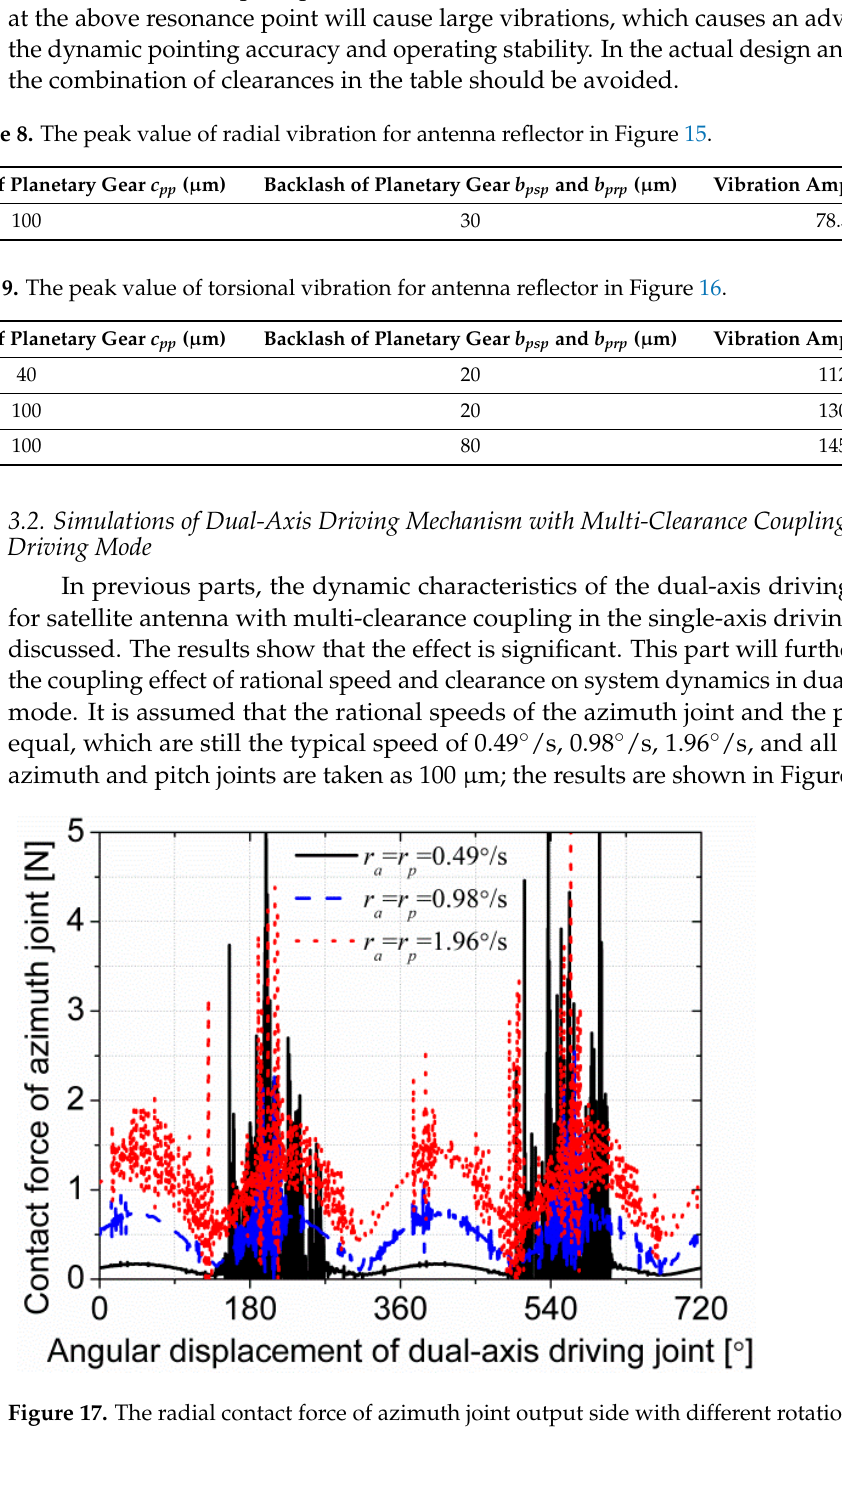
Figure 18. The radial contact force of pitch joint output side with different rotational speeds.